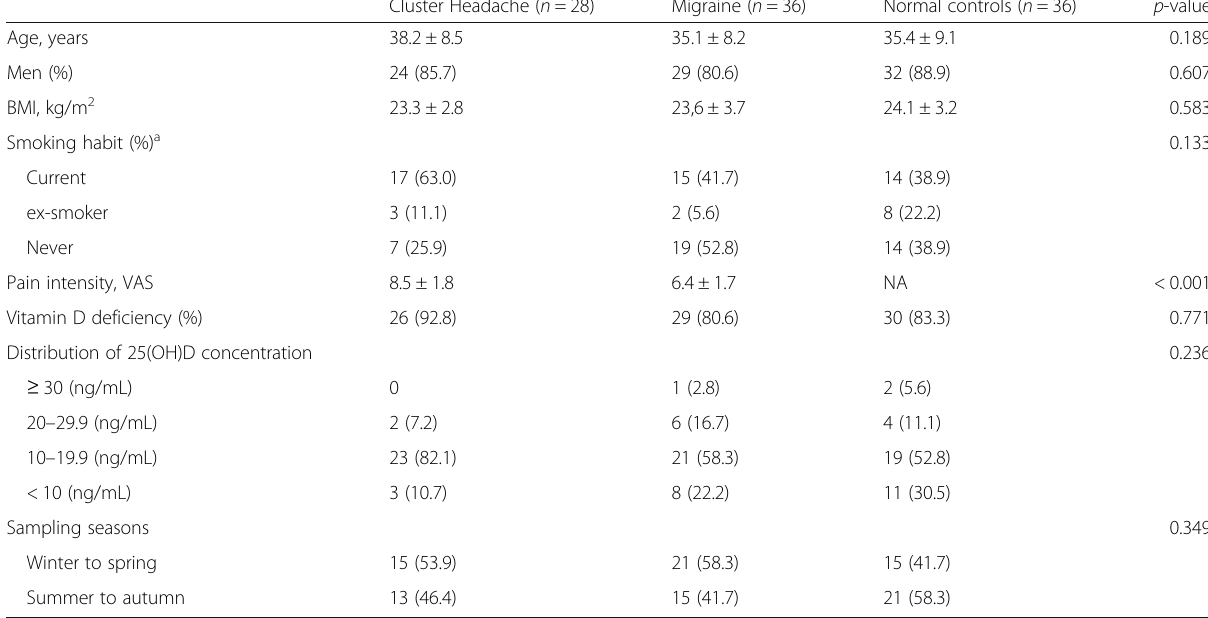
Table 1 Demographic features and vitamin D parameters of the patients with cluster headache, migraineurs, and normal